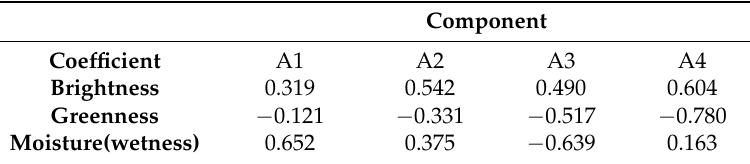
Table 5. Conversion coefficient of tasseled cap for QuickBird images.